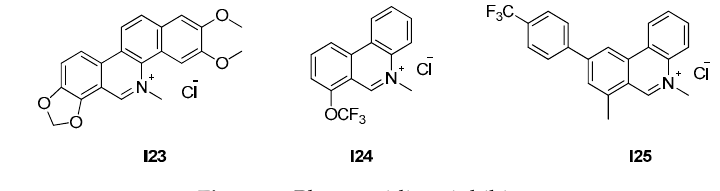
Figure 9. Phenantridium inhibitors. Table 9. MICs of phenantridium inhibitors I23–I25.